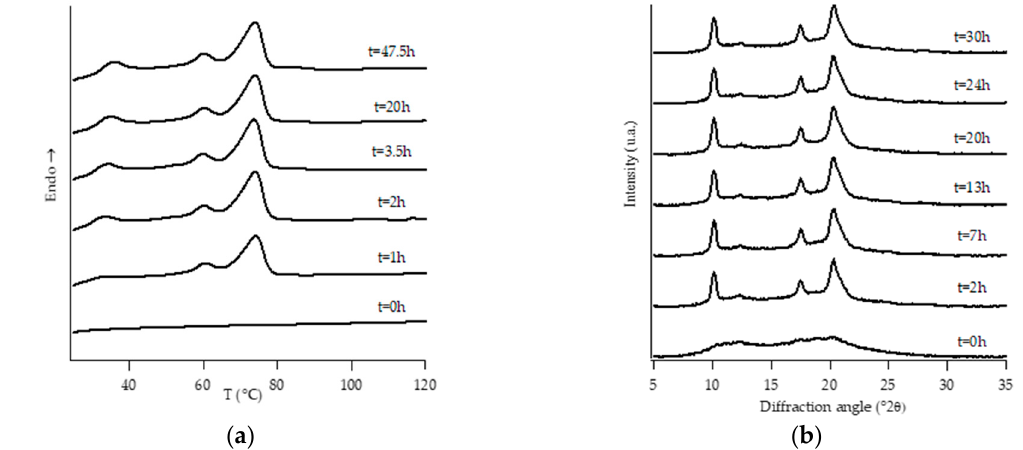
Figure 4. DTA thermograms ( a ) and WAXD patterns ( b ) of PB2.9 at different aging times.